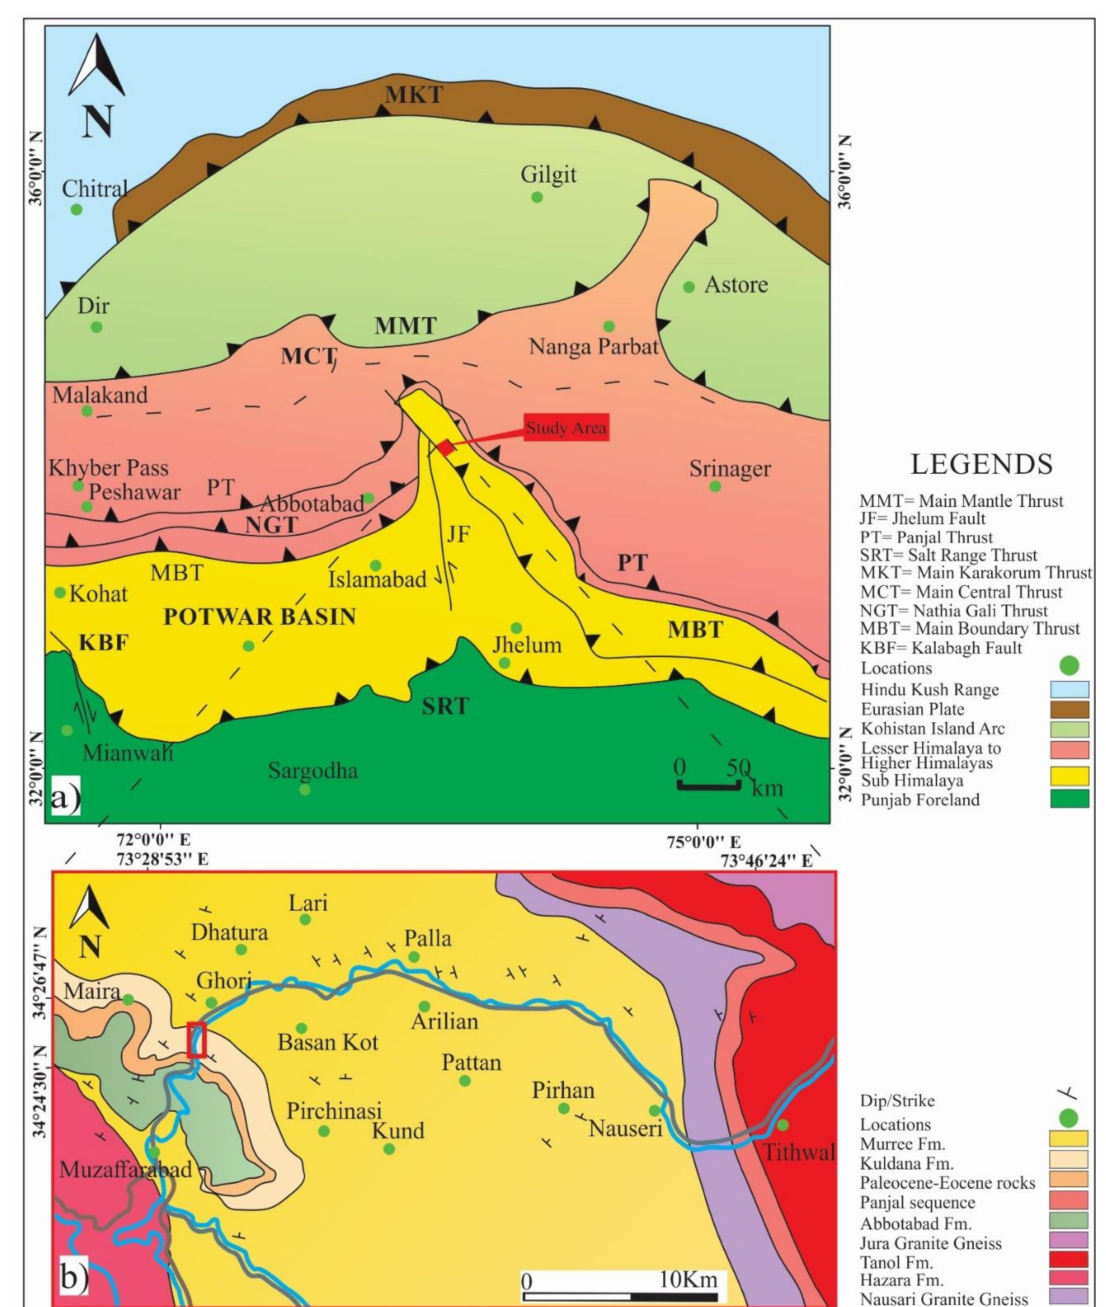
Figure 1. ( a ) A northern Pakistan’s tectonic map; ( b ) a geological map of the Kuldana Formation in the Yadgaar Section Muzaffarabad area, showing sample